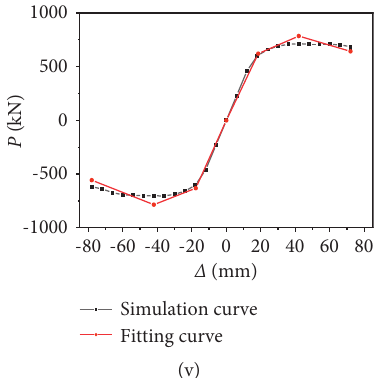
Figure 11: Comparisons of skeleton curve model between calculation and simulation. (a) STHCC1. (b) STHCC2. (c) STHCC3. (d) STHCC4. (e) STHCC5. (f) STHCC6. (g) STHCC7. (h) STHCC8. (i) STHCC9. (j) STHCC10. (k) STHCC11. (l) STHCC12. (m) STHCC13. (n) STHCC14. (o) STHCC15. (p) STHCC16. (q) STHCC17. (r) STHCC18. (s) STHCC19. (t) STHCC20. (u) STHCC21. (v)